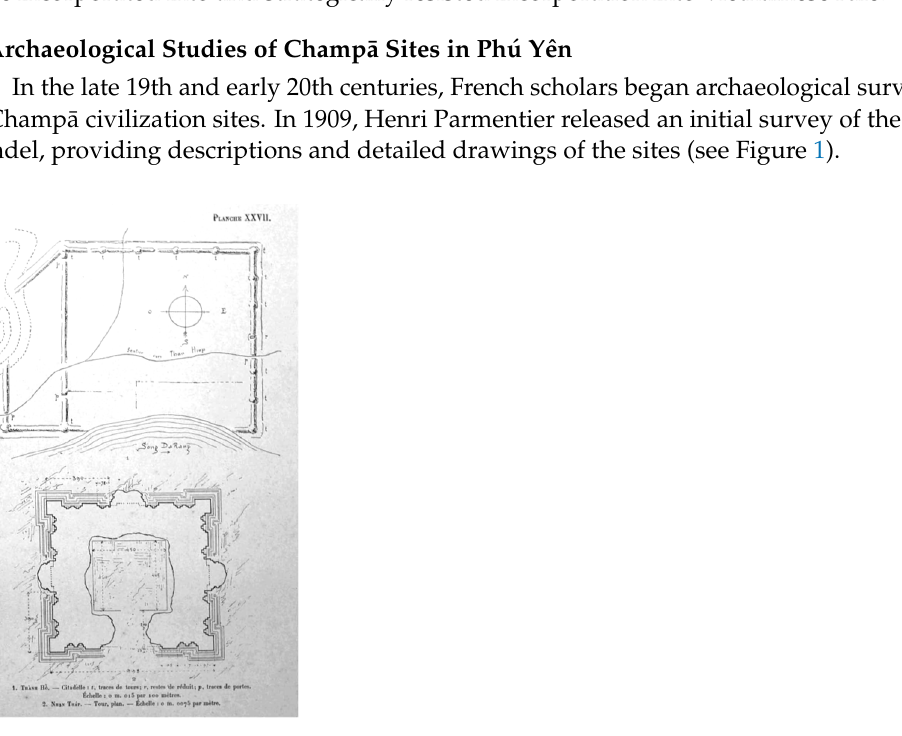
Figure 2. Edge of H ồ Citadel, Blended into Edge of Agricultural Landscape and the Local Forest (Photograph by Qu ả ng V ă n S ơ n). As we can see from Figure 2, the edges of the walls of the citadel blend very naturally into the local agricultural landscape, which has included farmland for Vietnamese fami- lies living in the area. Nonetheless, the brick constructions of the H ồ Citadel were very large by Champ ā standards, rising to approximately 0.1 m, with deep red hues that are sometimes crimson, almost purplish, in color. The production site appears to have been located relatively nearby at Ph ướ c Th ị nh, along the north–south axis of the region and across the Đ à R ằ ng River, based on finds of numerous broken bricks at that location (Par- mentier 1909a, pp. 137–38; Ngô 2002, pp. 2, 10–11). Vietnamese nationals have surveyed Champ ā relics in Phú Yên many times since Parmentier’s works, especially in the 1990s and early decades of the 21st century. A substantial expedition led by Lê Đ ình Ph ụ ng, Vietnam’s Institute of Archaeology, and the Phú Yên Museum was completed in 2003; on the other hand, a later survey in 2008–2009 was conducted by a team affiliated with the University of Social Sciences and Humanities. These surveys emphasized the importance of the H ồ Citadel as a military, political, and cultural center (Ngô 2002; Nguy ễ n 2004, 2010; Đặ ng et al. 2009; Lâm 2019). However, most of these examinations focused on specific